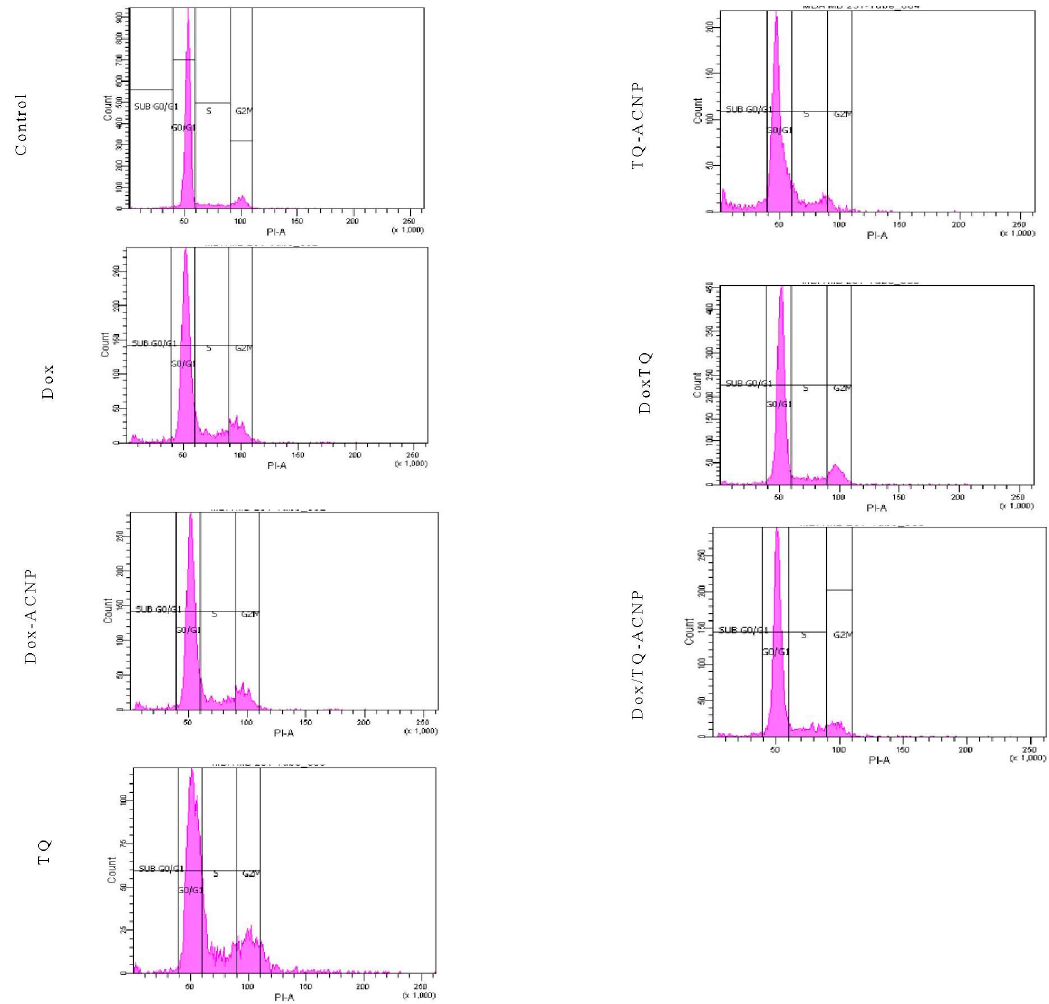
Figure 18. Flow cytometry data showing the effect of various treatments on the cell cycle distribution of 3D mammosphere cells at 48 h. Int. J. Mol. Sci. 2019 , 20 , x FOR PEER REVIEW